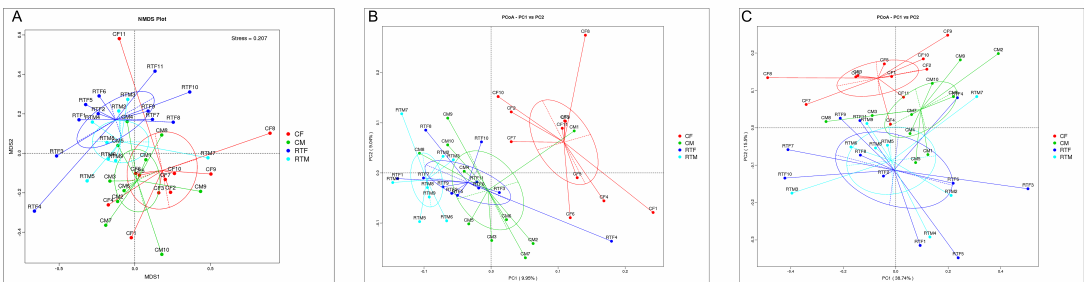
Figure 5. ( A ) Non-Metric Multi-Dimensional Scaling (NMDS) analysis of the gut microbiota of the o ff spring, ( B ) PcoA analysis of the gut microbiota of the o ff spring (unweighted), ( C ) Principal Co-ordinates Analysis (PcoA) analysis of the gut microbiota of the o ff spring (weighted). Cold female (CF), cold male (CM), room temperature female (RTF), and room temperature male (RTM). Multi Response Permutation Procedure (MRPP) was used to verify the prenatal cold stress e ff ect